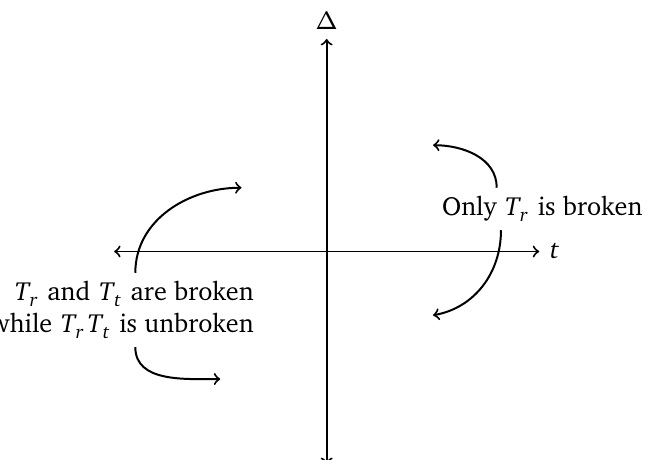
Figure 2: Phase diagram of the model Hamiltonian Eq. (6). The symmetry breaking pattern only depends on the sign of t